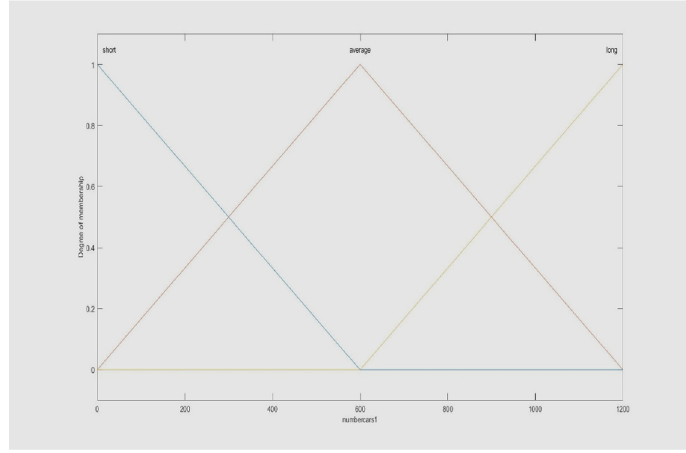
Figure 2. First input to the fuzzy controller for junction 1 with three linguistic values.